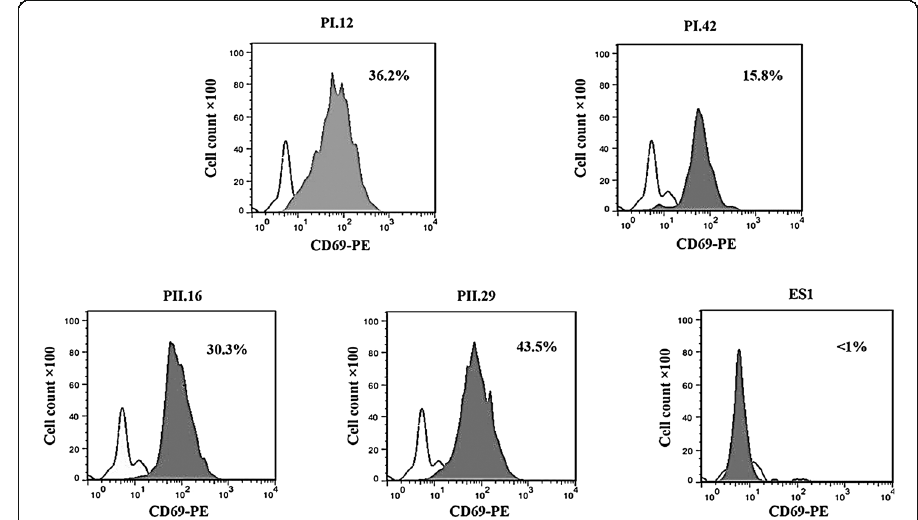
Fig. 3 The effects anti-4-1BB scFvs on the expression of the T-cell activation marker CD69. T cells were cultured at 10 6 cells/well in a 24-well plate, activated with anti-4-1BB scFvs and analyzed for CD69 expression using anti-CD69 PE antibody. The expression level of CD69 increased on T cells activated with PI.12, PI.42, PII.16 and PII.29 scFvs, but not with ES1 control scFv. These results are representative of at least three independent experiments. Dotted line histograms indicate untreated control T cells and gray filled histograms indicate T cells treated with anti-4-1BB and ES1